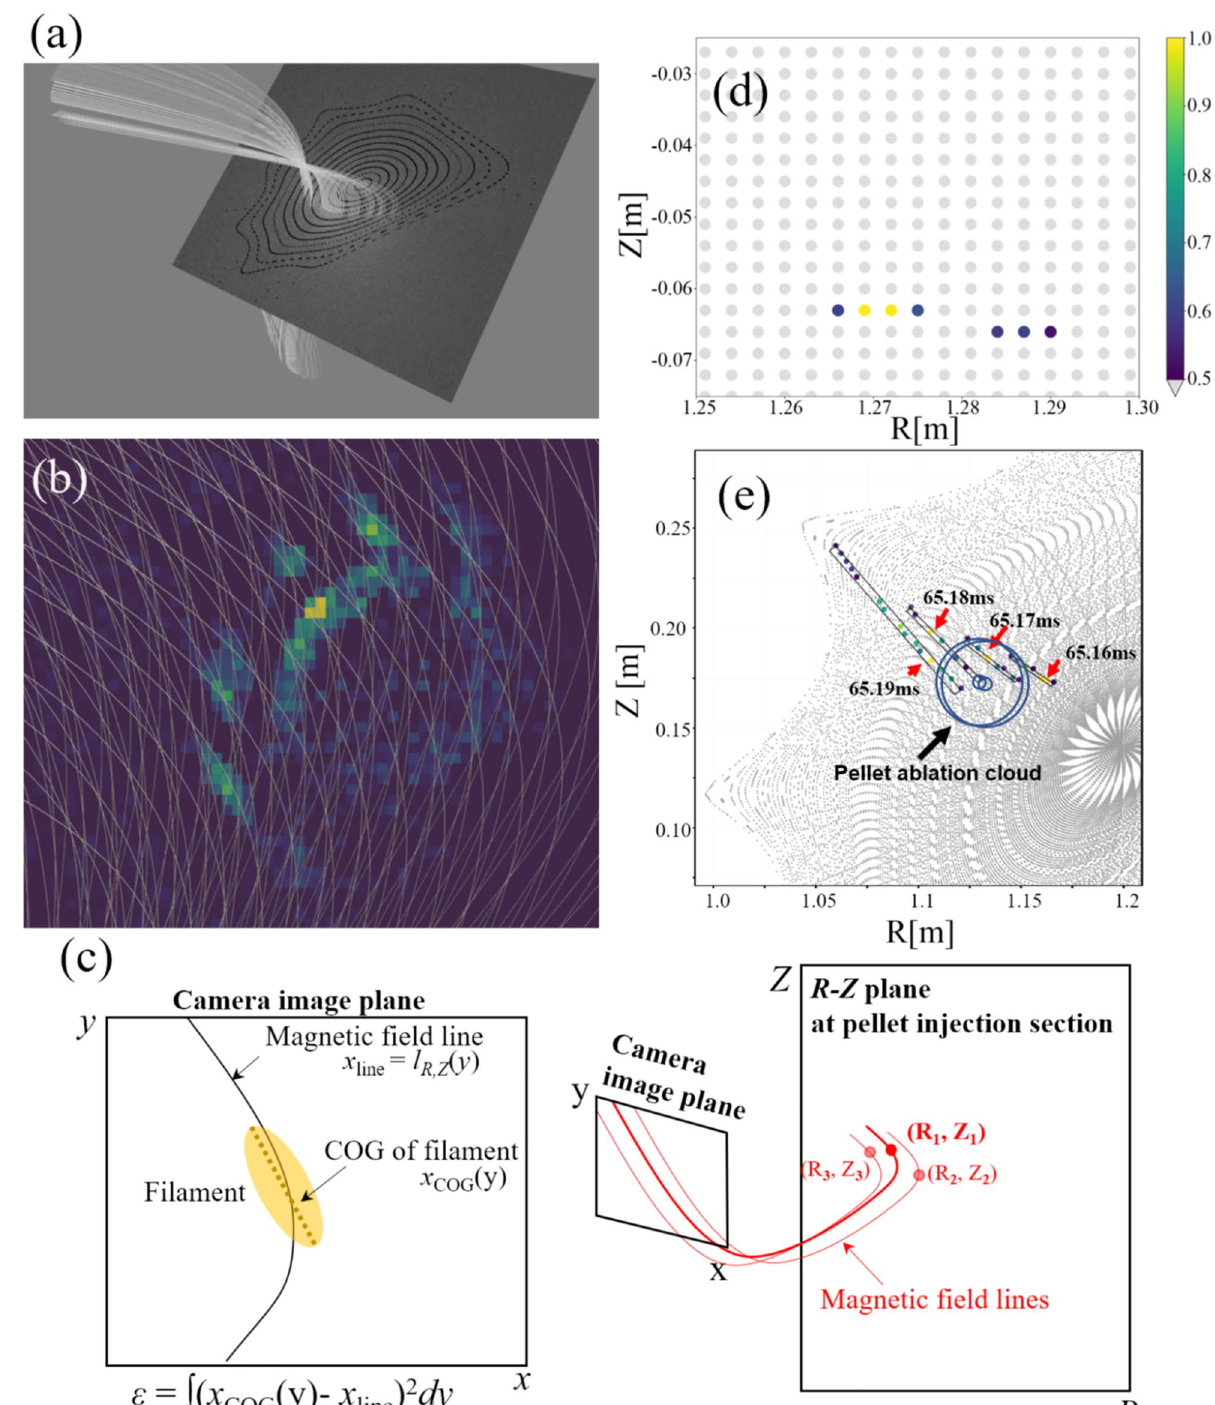
Figure 4. ( a ) Flux surface at the pellet injection toroidal section (#11.5) and representative magnetic field lines observed from the camera on the 3D model drawn by “Blender”. ( b ) Superimposed image of fluctuation structure and typical magnetic field lines. Different magnetic field lines are stacked with different tilt angles in the depth direction of the camera’s line of sight. ( c ) A schematic of the analysis procedure for localizing fluctuation. ( d ) A typical distribution of scoring parameter s, projected on the R-Z plane from x–y coordinates, at the toroidal section of the pellet injection port with a 3 mm spatial resolution. Only the points with s > 0.5 are shown as color here. ( e ) Time evolution of parameter s for a single, identical fluctuation. The color of points represents the s value, as well as ( d ). The circles indicate the ablation cloud of the pellet. While the fluctuation propagates around the pellet, the pellet itself does not move so much compared with the motion of the fluctuation structure. Note that the field line location where the fluctuation exists can be projected on the poloidal cross-section of the pellet injection port, as shown in ( c ). The detail of the three-dimensional motion of fluctuation is discussed in Figs. 5 and